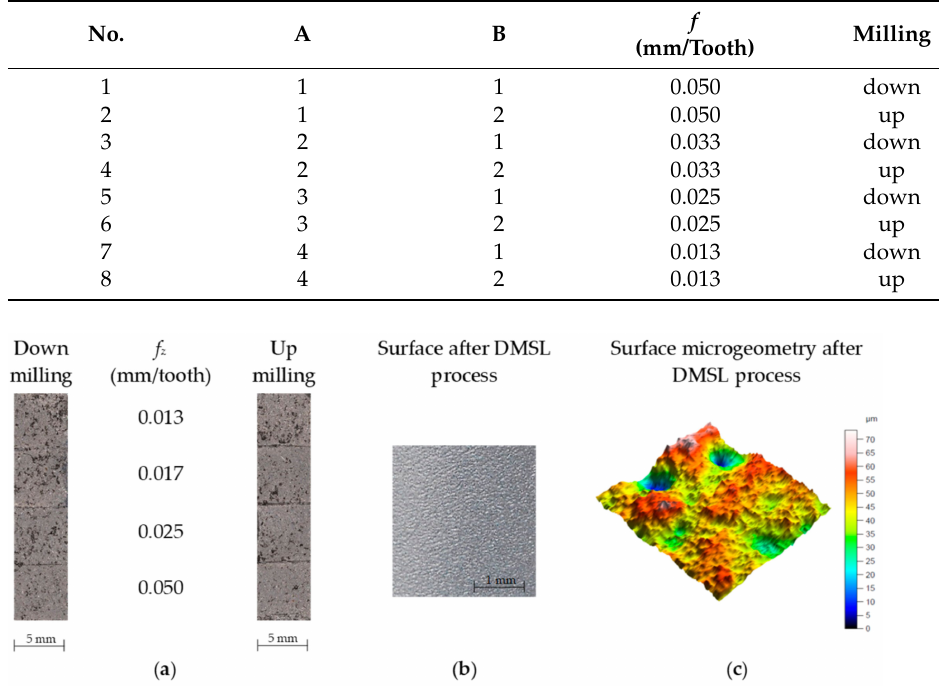
Figure 2. Surface after down and up milling ( a ) and before machining ( b ) including microgeometry ( c